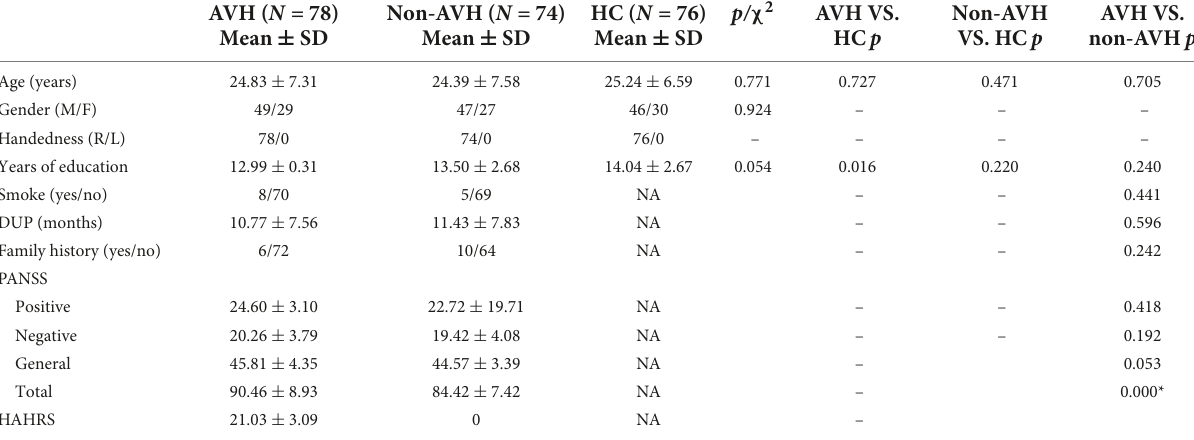
TABLE 1 Comparisons of demographic and clinical characteristics in AVH, non-AVH, and HC groups.